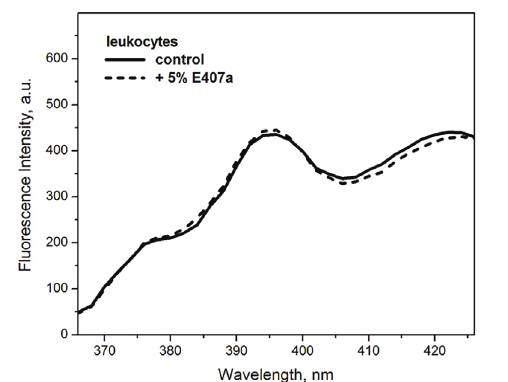
Figure 2. Representative fluorescence spectra of probe PH1 in leukocyte suspensions: (a) control samples containing leukocytes obtained from the intact rats (solid line), (b) leukocytes treated with the 5% E407a solution during 4 h (dashed line).